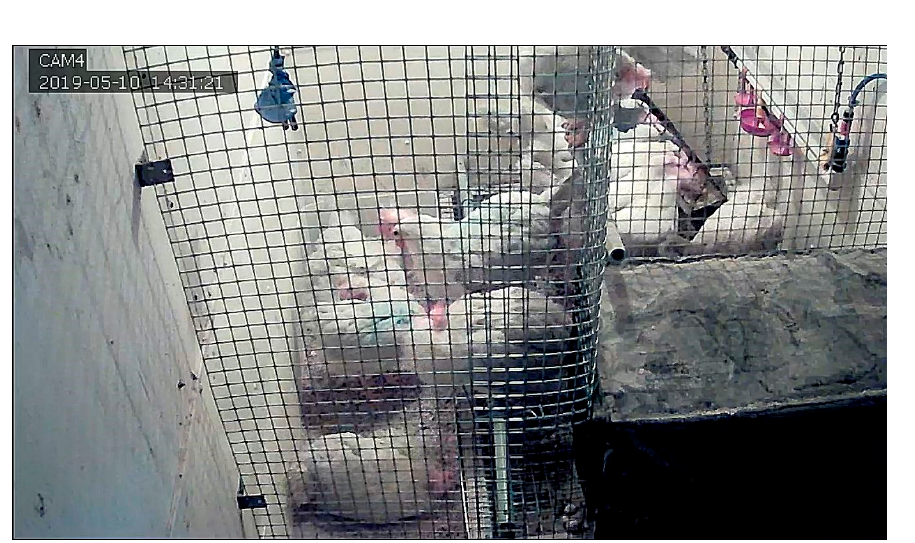
Figure 2. Video recording at an experimental room.